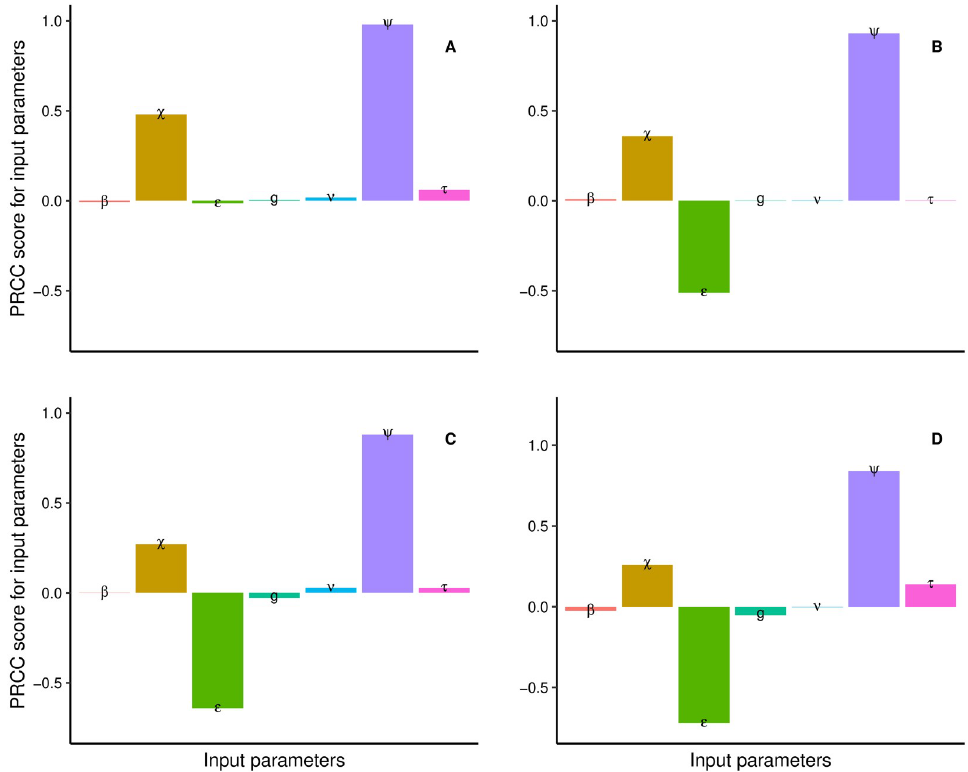
Fig 4. PRCC output for all input parameters with respect to the extinction probability. (A). Sampling � between 0.999 and 1. (B). Sampling � between 0.855 and 1. (C). Sampling � between 0.51 and 1. (D). Sampling � between 0.1 and 1. ψ is the daily mortality rate for females, χ the daily mortality rate for female pupae, β the probability deposited larva is female, � probability female is inseminated by a fertile male, τ the inter-larval period, g pupal duration and ν time from female emergence to first